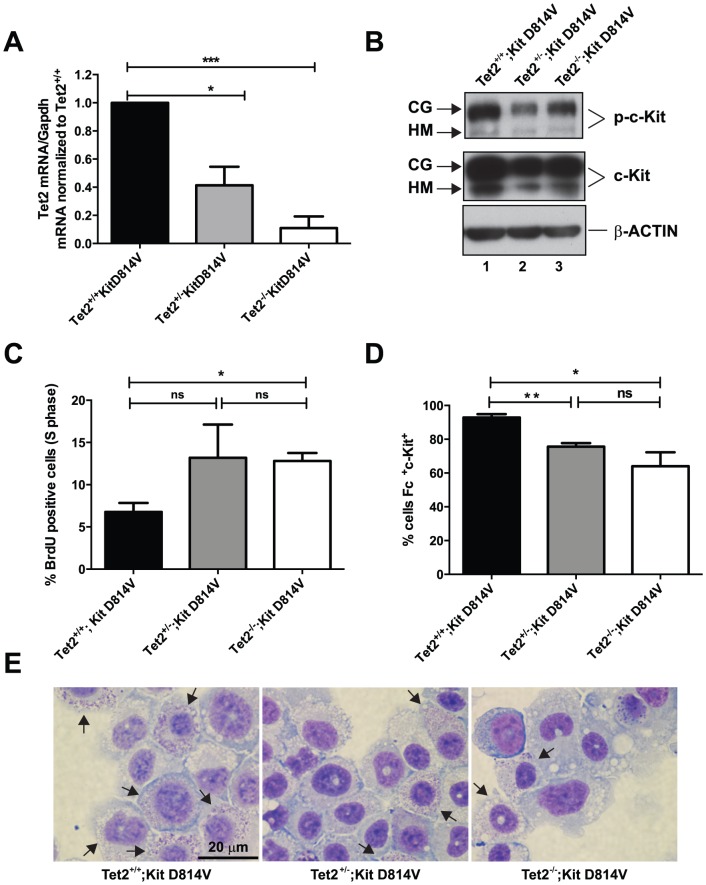
Effects of loss of Tet2 on BMMCs derived from Kit D814V-MxCre mice.
A) Tet2 mRNA levels measured in BMMCs upon Mx1-Cre-mediated deletion of Tet2. Data are presented as fold change of Tet2 mRNA/Gapdh mRNA levels relative to Tet2+/+;Kit D814V. Data represent mean ±SEM, n = 3, *P = <05, ***P<.001. B) Phosphorylation of the Kit receptor in the absence of its ligand SCF due to the presence of a Kit activating mutation in BMMCs from Tet2+/+;Kit D814V, Tet2+/−;Kit D814V and Tet2−/−;Kit D814V animals. The western blot shown is representative of two independent experiments with similar results. Two different glycosylated forms of the Kit receptor are indicated. CG = complex glycosylation form; HM = high-mannose form. Total levels of c-KIT and β-actin are shown as loading controls. C) Proliferation of BMMCs carrying the Kit D814V mutation upon loss of Tet2. Data show average percentage ±SEM of BrdU-positive BMMCs across genotypes, n = 3, *P<.05, ns  =  not significant. D) Differentiation of Kit D814V positive BMMCs in the absence of Tet2. Data show average percentage ±SEM of double positive (Fcε+c-Kit+) BMMCs from Tet2+/+;Kit D814V, Tet2+/−;Kit D814V and Tet2−/−;Kit D814V (64.1±8.2) after 4 weeks in culture with mIL-3. n = 3, *P = <05, **P<.01, ns = not significant E) Representative images of Tet2+/+;Kit D814V,Tet2+/−;Kit D814V and Tet2−/−;Kit D814V BMMCs. Scale bar  = 20 µm. Arrows indicate cells containing granules, which is indicative of a more differentiated phenotype.